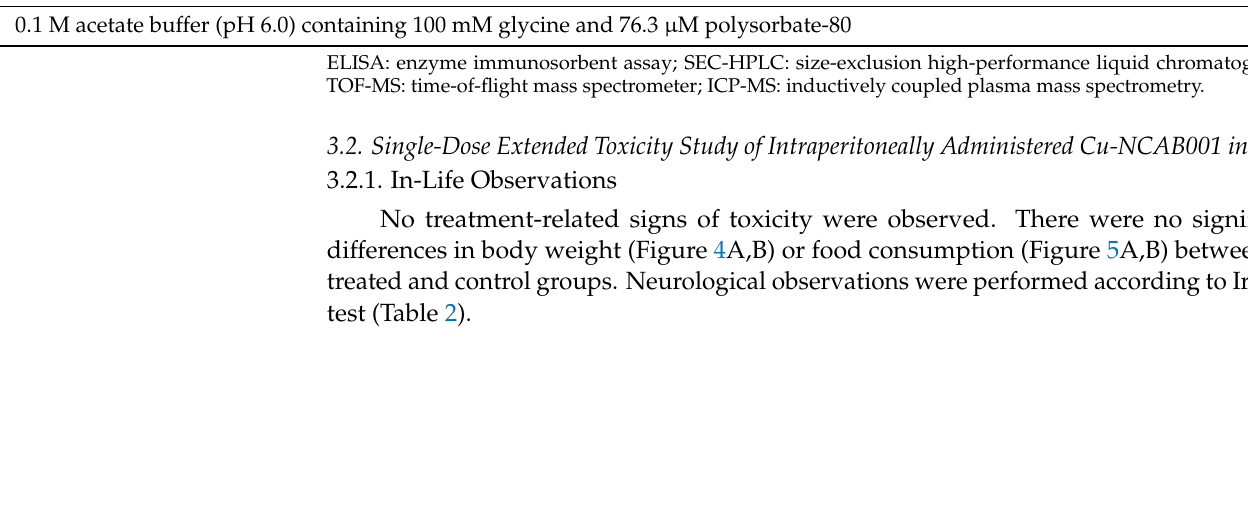
Figure 4. Changes in the body weights of mice after the intraperitoneal administration of Cu- NCAB001. Plots of the average body weight of ( A ) male and ( B ) female mice in each treatment group of the extended single-dose toxicity study are shown. Values are presented as mean ± SD. The means were calculated based on the following number of values: days 0 and 1, vehicle and 625 μ g/kg groups, n = 15; 62.5 μ g/kg group, n = 10; day 3 and thereafter, vehicle and 625 μ g/kg groups, n = 5. As there were no significant differences in histopathological observations between the 625 μ g/kg-